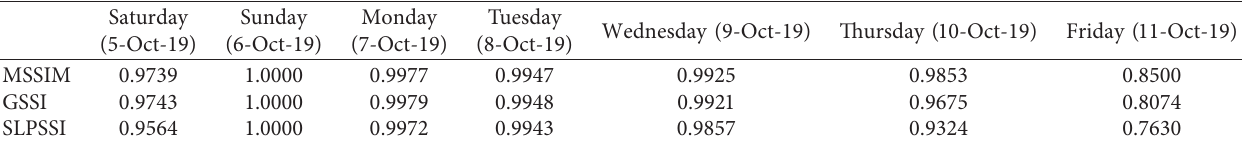
Table 4: The value comparison of GSSI, MSSIM, and SLPSSI between Sunday and other